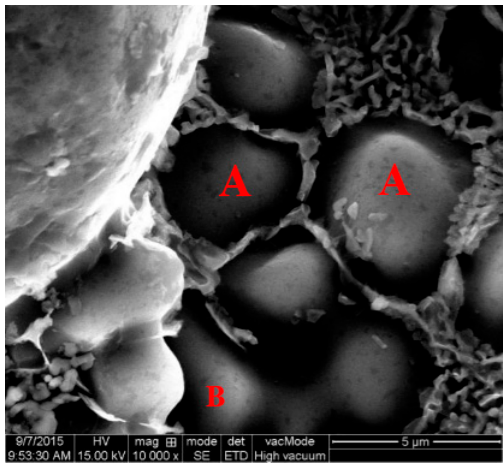
Figure 11. Morphology of α 2 particles (A) equiaxed crystals and (B) “8” or “shuttle” shaped particles.